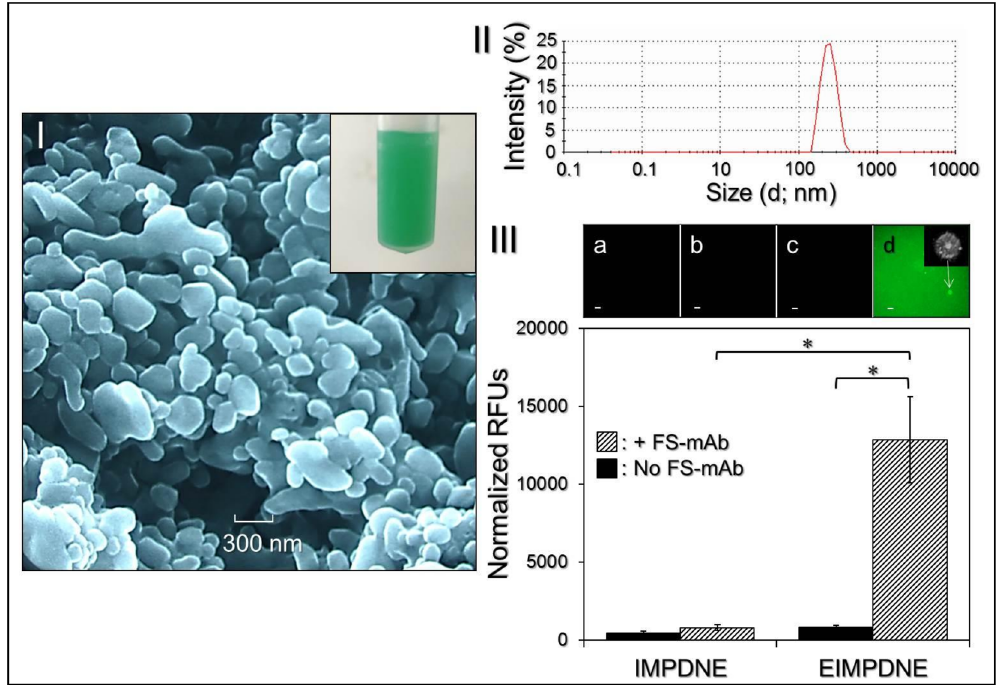
Figure 2. Assessment of physical and chemical properties of the EIMPDNEs. ( I ) SEM image of the EIMPDNEs detected at 10,000 × magnification. The inset photograph shows the appearance of the EIMPDNE sample. ( II ) Size distribution profile of the EIMPDNEs measured by DLS technique. ( III ) Validation of the presence and bioactivity of anti-EGFR-mAbs on the EIMPDNE surface. The upper photographs are the representative fluorescence microscopic images of the IMPDNEs ( a , b ) and EIMPDNEs ( c , d ) without ( a , c ) and with ( b , d ) FS-mAb conjugation at 200 × magnification. Scale bar = 5 µ m. The inset photomicrographic image in Figure 2IIId represents an EIMPDNE under optical microscopy at 400 × magnification. The fluorescence level expressed from each group was detected using a fluorospectrometer set at an excitation wavelength of 488 nm and emission wavelength of 525 nm, and was quantitatively represented and analyzed by relative fluorescence units (RFUs) after normalization against the background signal. Values are mean ± s.d. ( n = 3). * p <